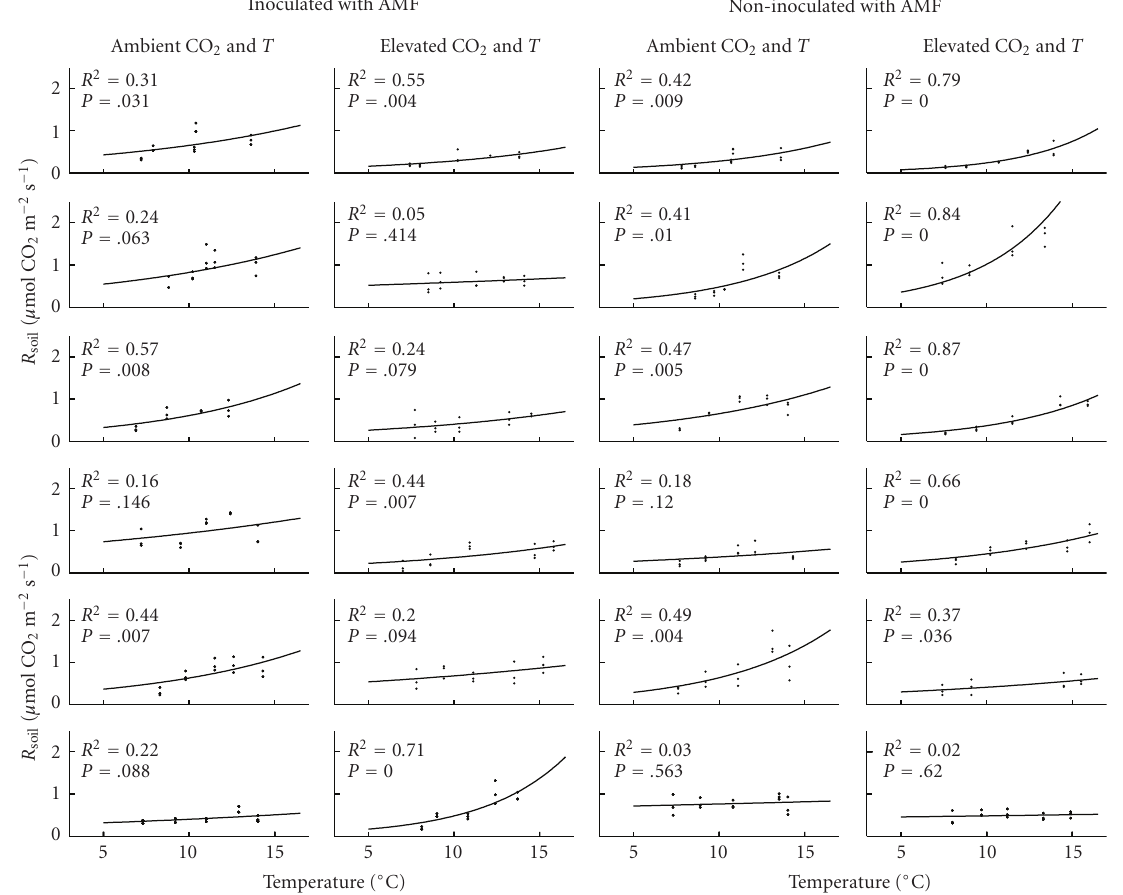
Figure 1: Soil respiration ( R soil ) in function of soil temperature, for all replicates of each treatment. Dots are measured values; the line represents the regression fitted with